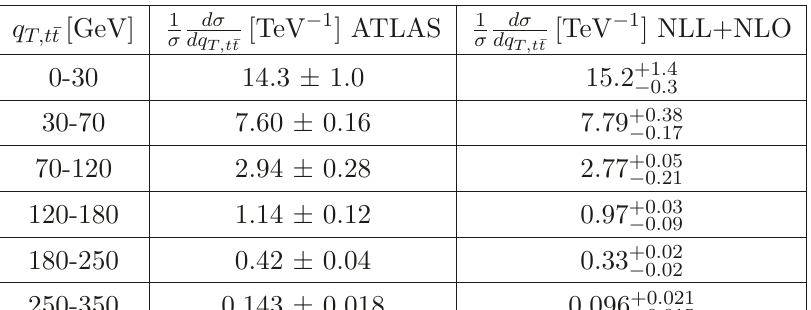
theoretical result (‘theory’) is the NLL+NLO prediction at central scales ( µ F = µ R = Q = m t ). As in the case of figure 3, the NLL+NLO results are obtained by using q T bins with